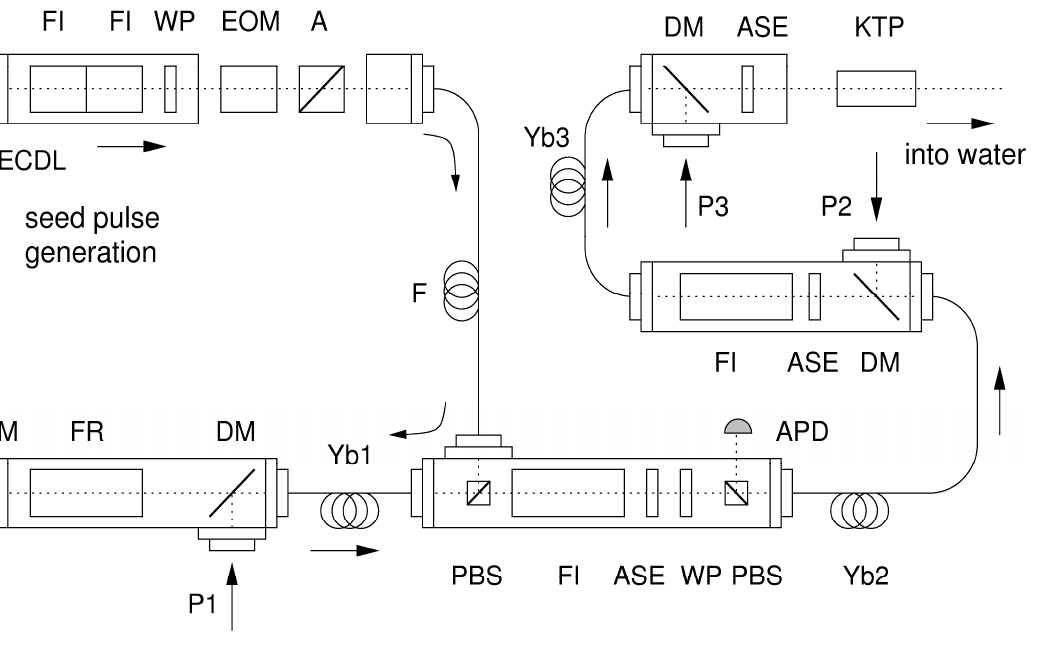
Figure 2 . Setup of the fiber amplifier: Yb-doped fibers (Yb1-3), seed laser (ECDL), patch fiber (F), pump lasers (P1-3), electro-optic modulator (EOM), analyzer (A), polarizing beam splitter (PBS), mirror (M), Faraday isolator (FI), Faraday rotator (FR), λ /2-wave plate (WP), dichroic mirror (DM), interference filters (ASE), avalanche photo diode (APD) and nonlinear KTP crystal (KTP).